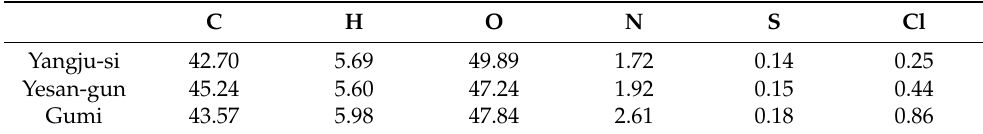
Table 1. Elemental analysis of pepper stems from each of the three sources. C H